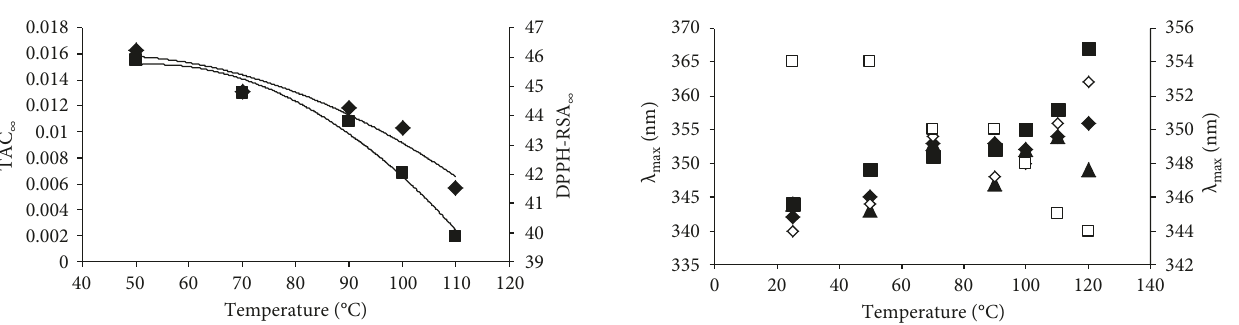
Figure 6: Heat-induced structural changes of anthocyanins from simulated and natural plum juices monitored as maximum emission wavelength ( λ max ) at different temperatures when excited at 270nm. PW (black diamonds), PCA (black squares), PS (black triangles), PM (empty diamonds), and PN (empty squares). Three independent tests were carried out in each case and SD was lower than 3.5%.